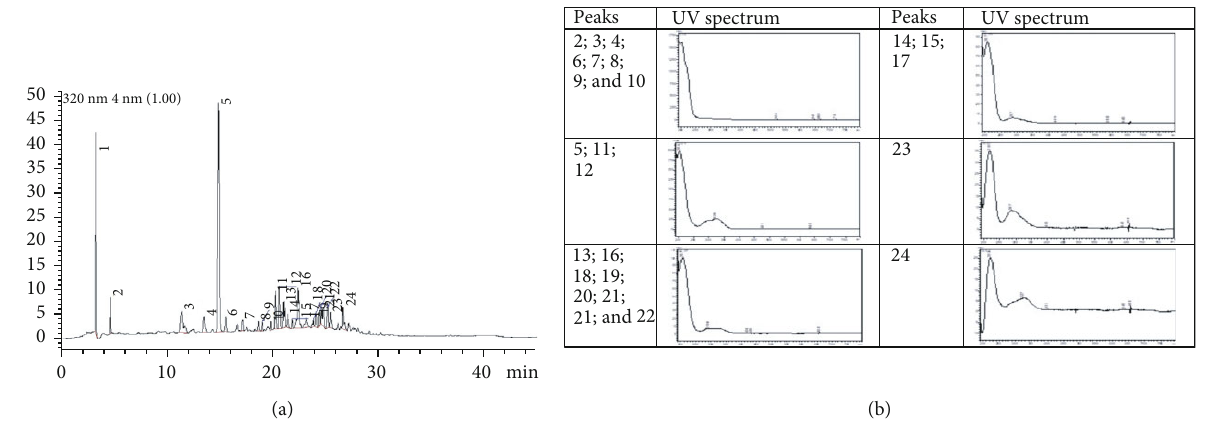
Figure 1: Chromatogram of the S. diploconos fruit extract at λ = 320 nm (a) and respective UV absorption spectra